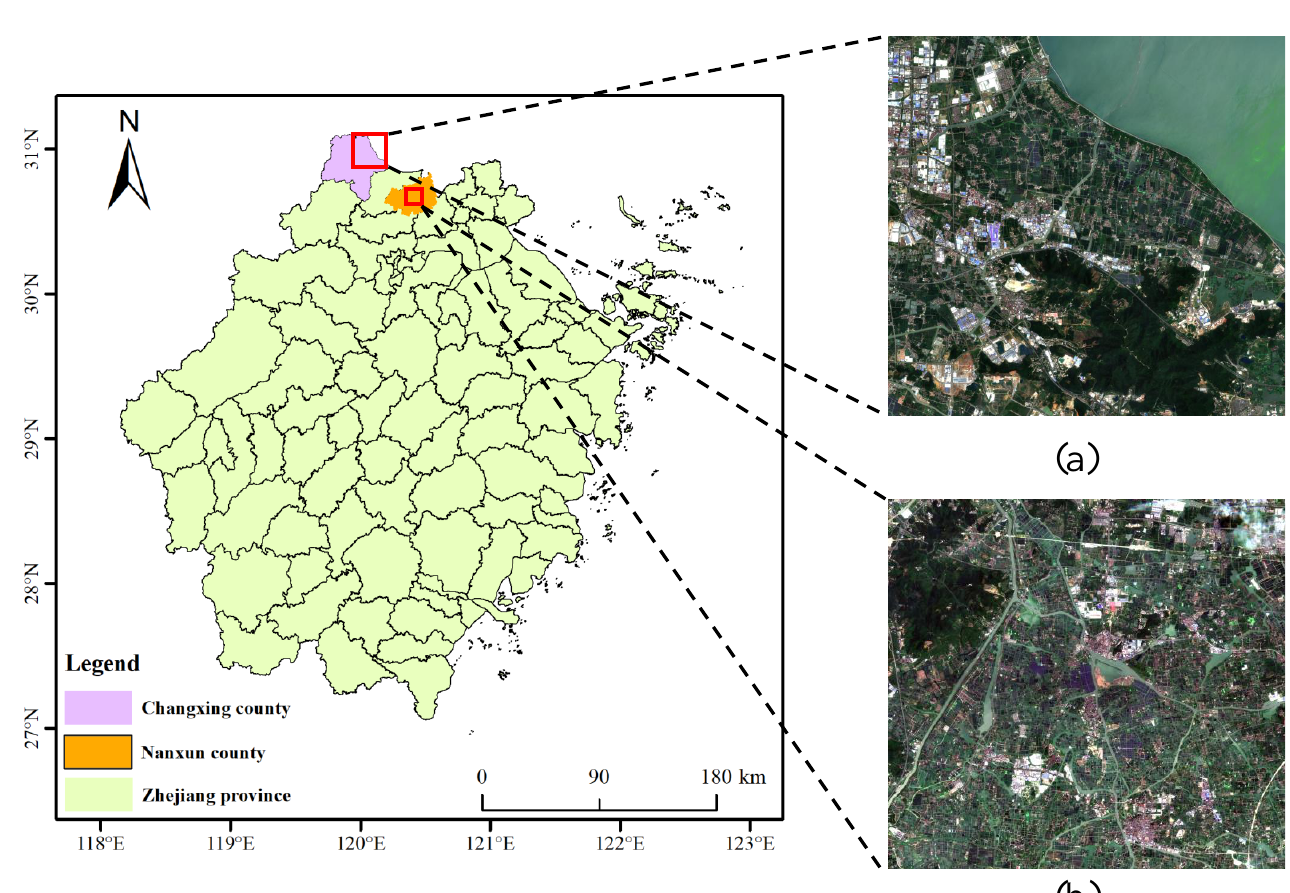
Figure 1. Location of Changxing County and Nanxun District, and Sentinel-2 remote sensing images. ( a ) Changxing County; and ( b ) Nanxun